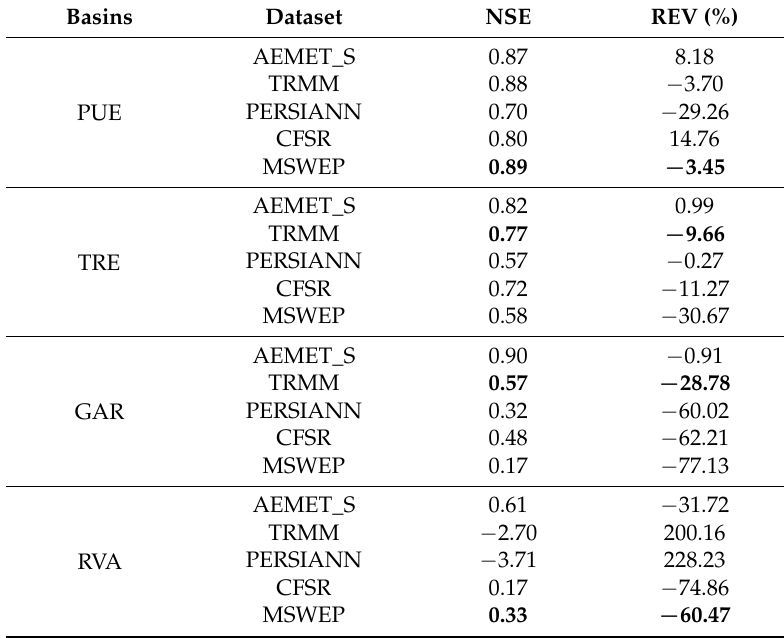
Table 7. NSE and REV of global precipitation datasets (GPDs) using the AEMET_G-calibrated GR2M (best results in bold).